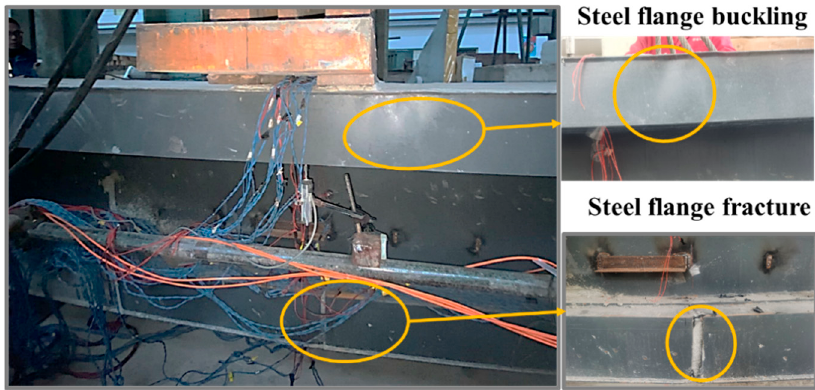
Figure 8. Failure mode of the steel part of the girder.